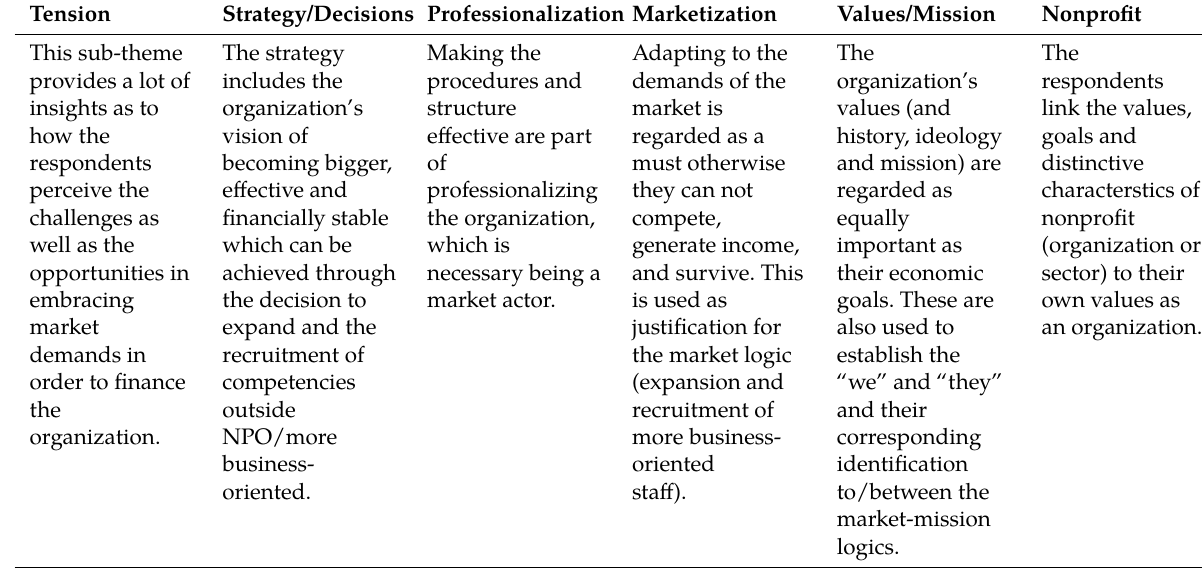
Table 2: Sub-themes regrouping.